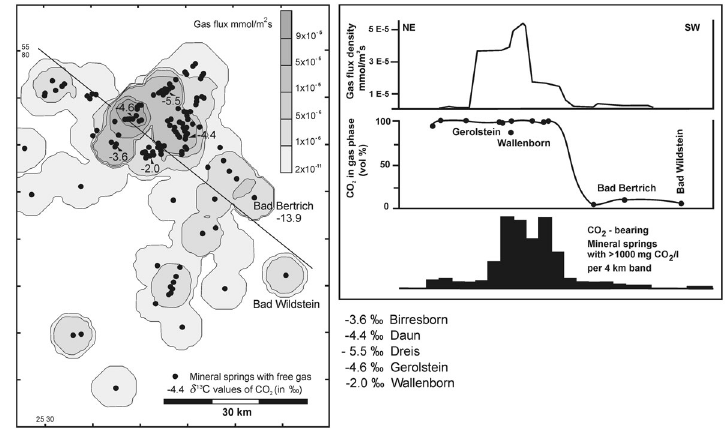
Fig. 2. Gas flux distribution (moving average for circles with 8.6 km diameter), isotope composition of CO 2 and schematic profile of CO 2 flux, spring density and gas composition across the West Eifel, after May (2002). Carbon iso- tope data from Griesshaber et al . (1992) and Hubberten (2004, pers. comm.). The Brubble spring of Wallenborn (wallen – seethe, born – spring) is a geyser-like spring with gas release of 11.3 m 3 per eruption period (May, 2002) the spring value (–2.0 ‰) in the West with the highest gas flux and the highest δ 13 C CO 2